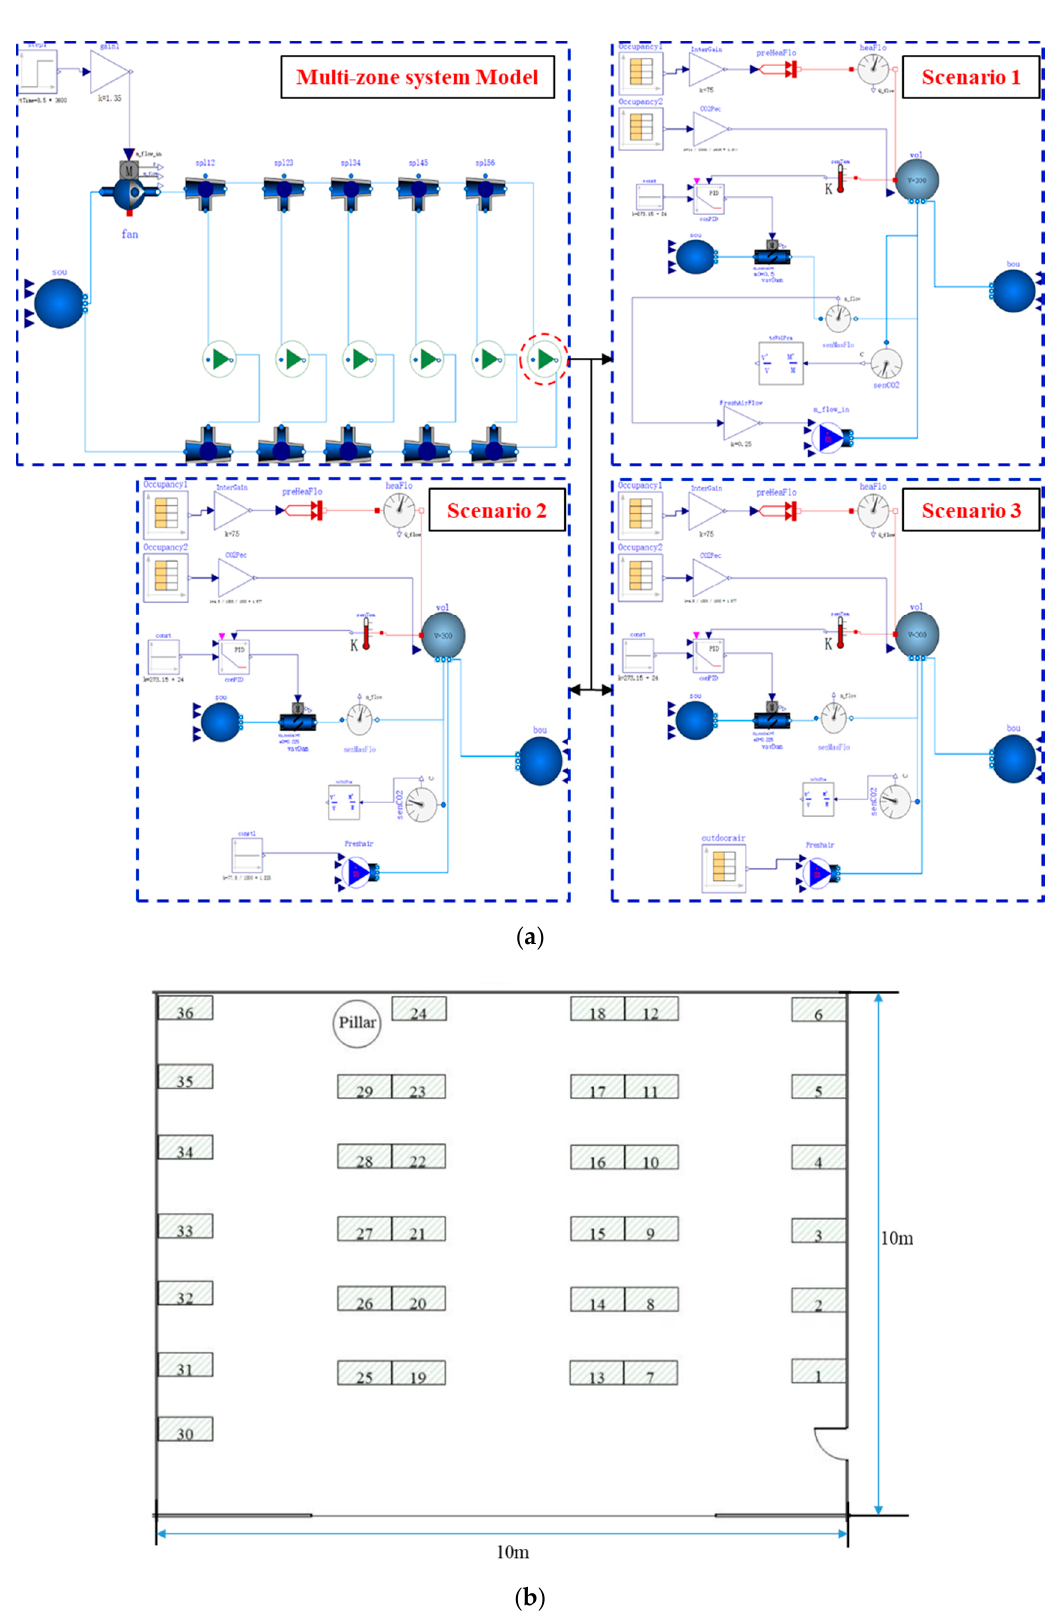
Figure 2. ( a ) Multi ‐ control strategies in the OpenModelica models of different scenarios; ( b ) Geometry of office rooms in the multi ‐ zone building.